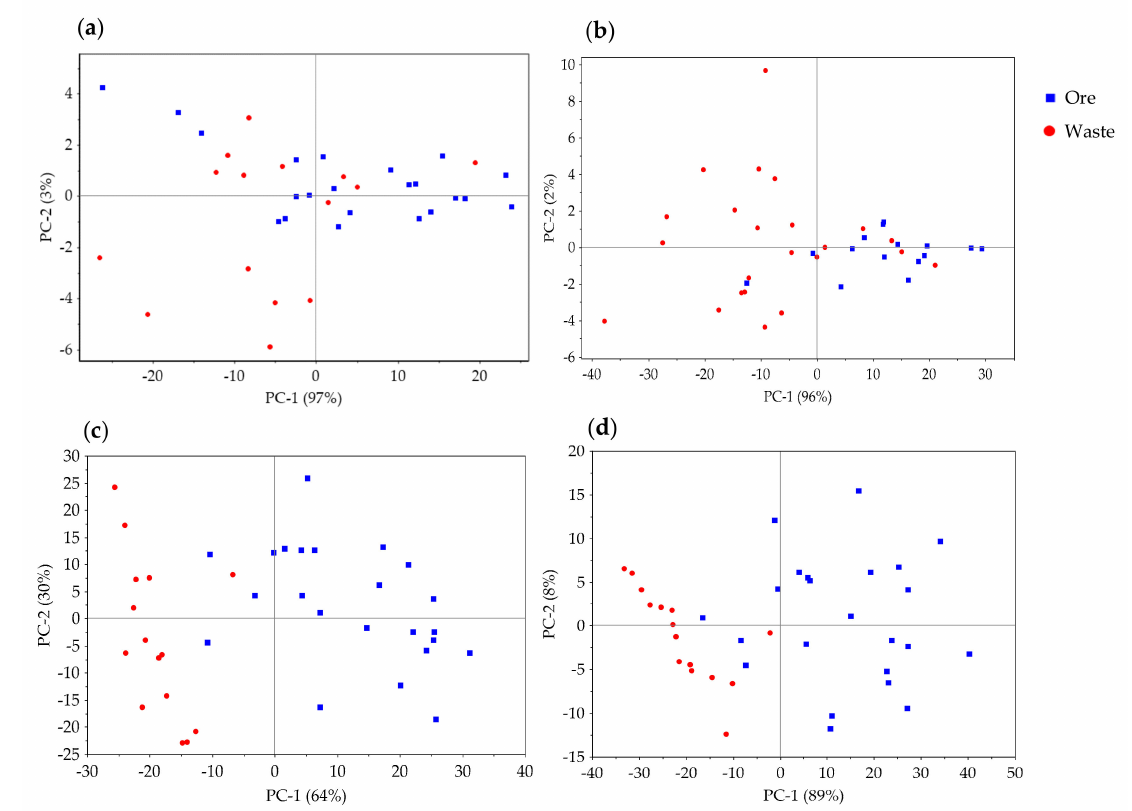
Figure 4. PCA model score plots of ( a ) VNIR, ( b ) SWIR, ( c ) MWIR and ( d ) LWIR showing the patterns of the ore and waste materials at 3% cut-o ff